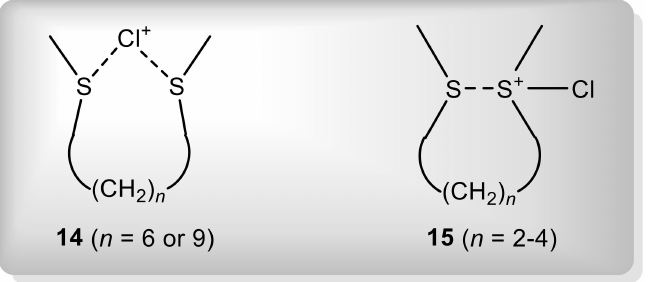
Figure 8. Structures suggested by DFT calculations for active chlorinating agents in presence of dithiaalkanes 13